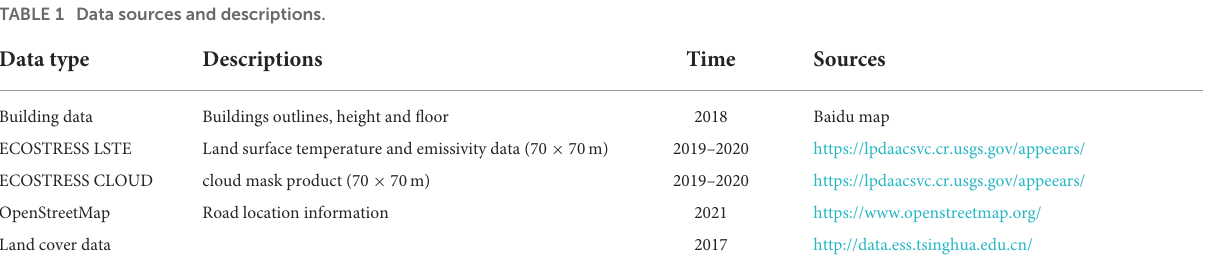
TABLE 1 Data sources and